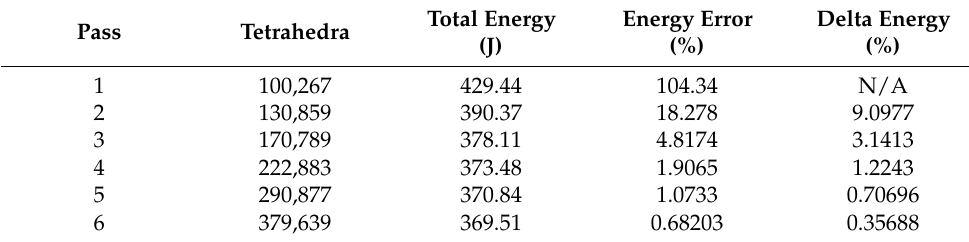
Table 4. Number of iterations of calculation with the Energy Error accepted for calculation. Total Pass Tetrahedra